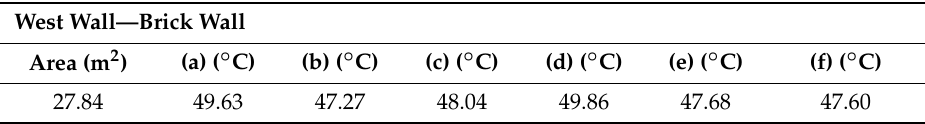
Table 3. Measured temperatures of the west wall for the initial configuration (a) and for the five case studies where positions/orientations of the fan heaters were changed (b–f).